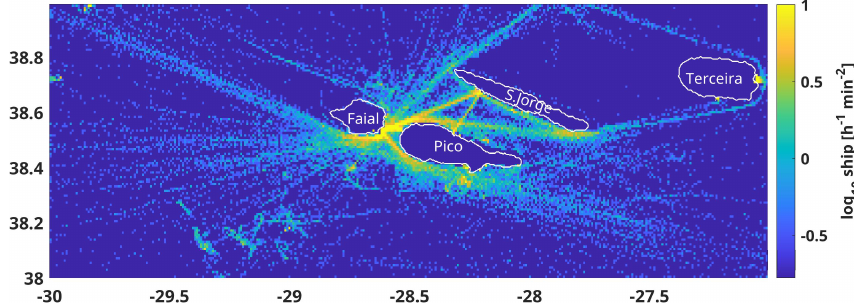
Figure 4. Cumulative ship density for the month of June 2018. Source: